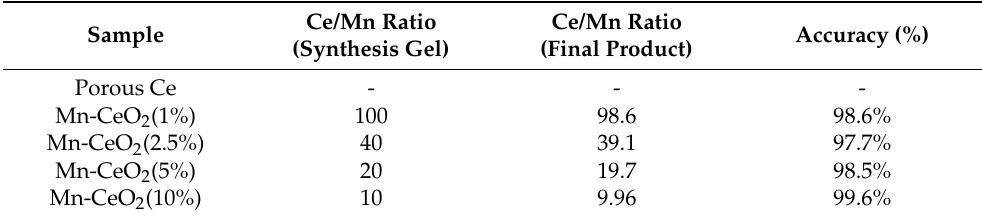
Table 1. A comparison between Ce/Mn ratio in the synthesis gel and the final solid product as obtained from ICP elemental